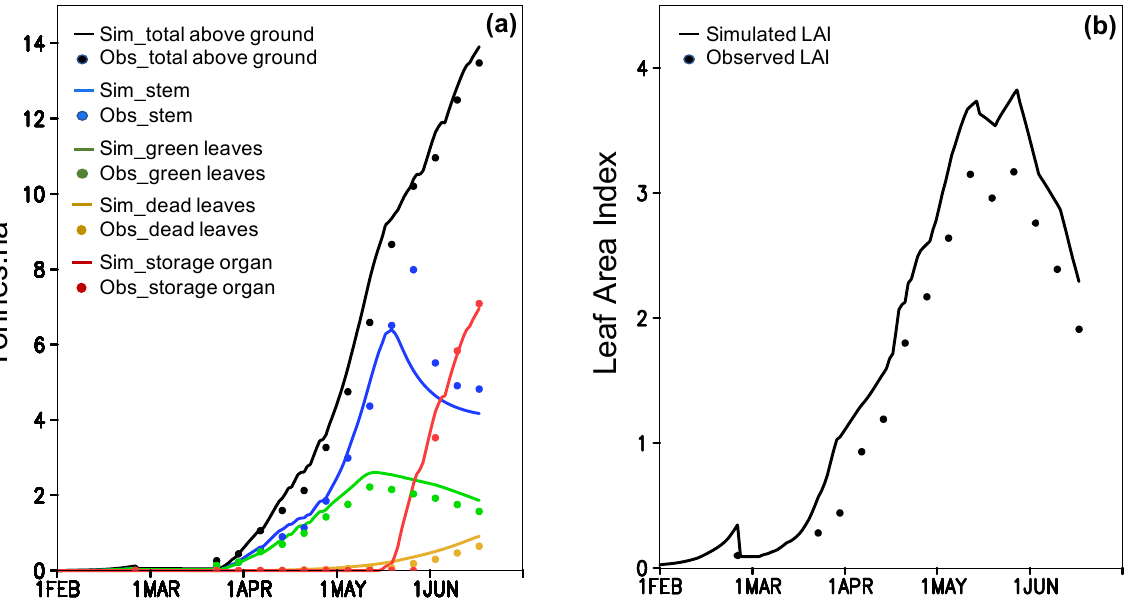
Figure 3. ORYZA(v3) model calibration by using experimental data from 2009; observed (Obs) and simulated (Sim) ( a ) biomass, and ( b ) Leaf Area Index (LAI).